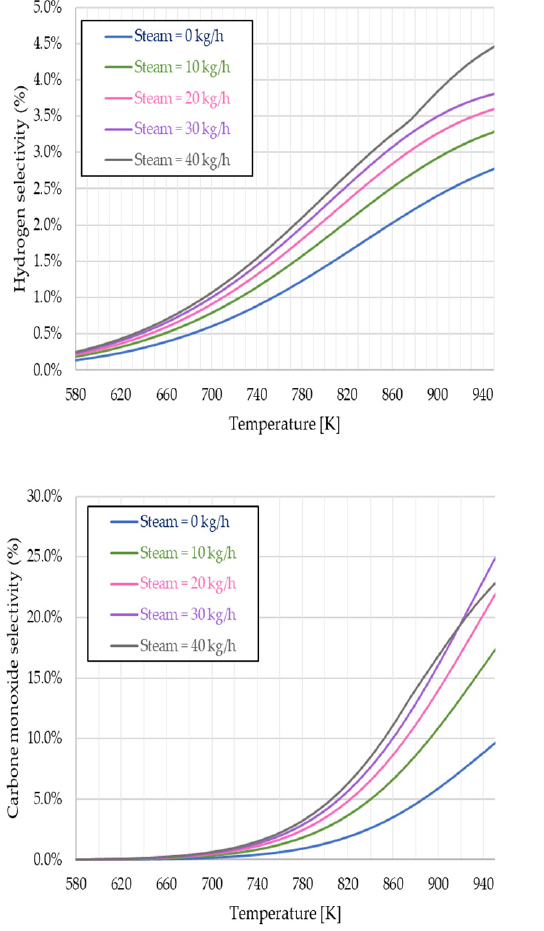
Figure 10 . The effect of temperature over components selectivity for different steam streams (a feed stream of 100 kg/h).